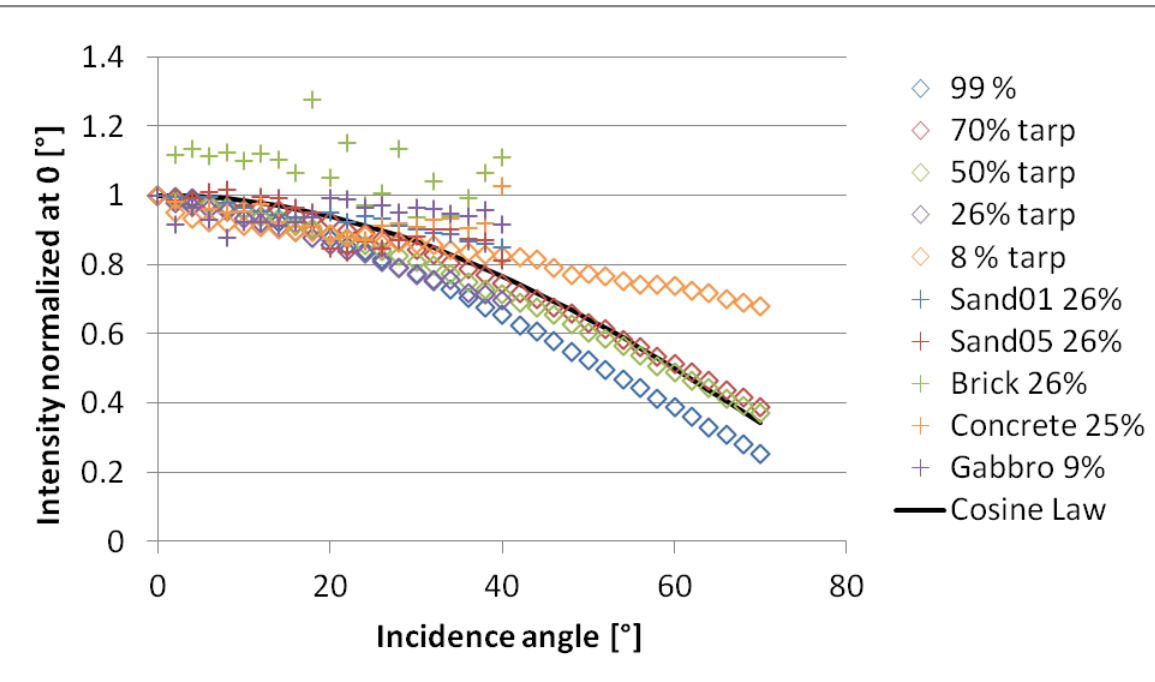
Figure 3. The effect of incidence angle on the intensity measured with the FARO scanner [28]. To compare the different targets and the Lambertian (cosine) scattering law, all results have been normalized to I(0 ° ) = 1 (see also